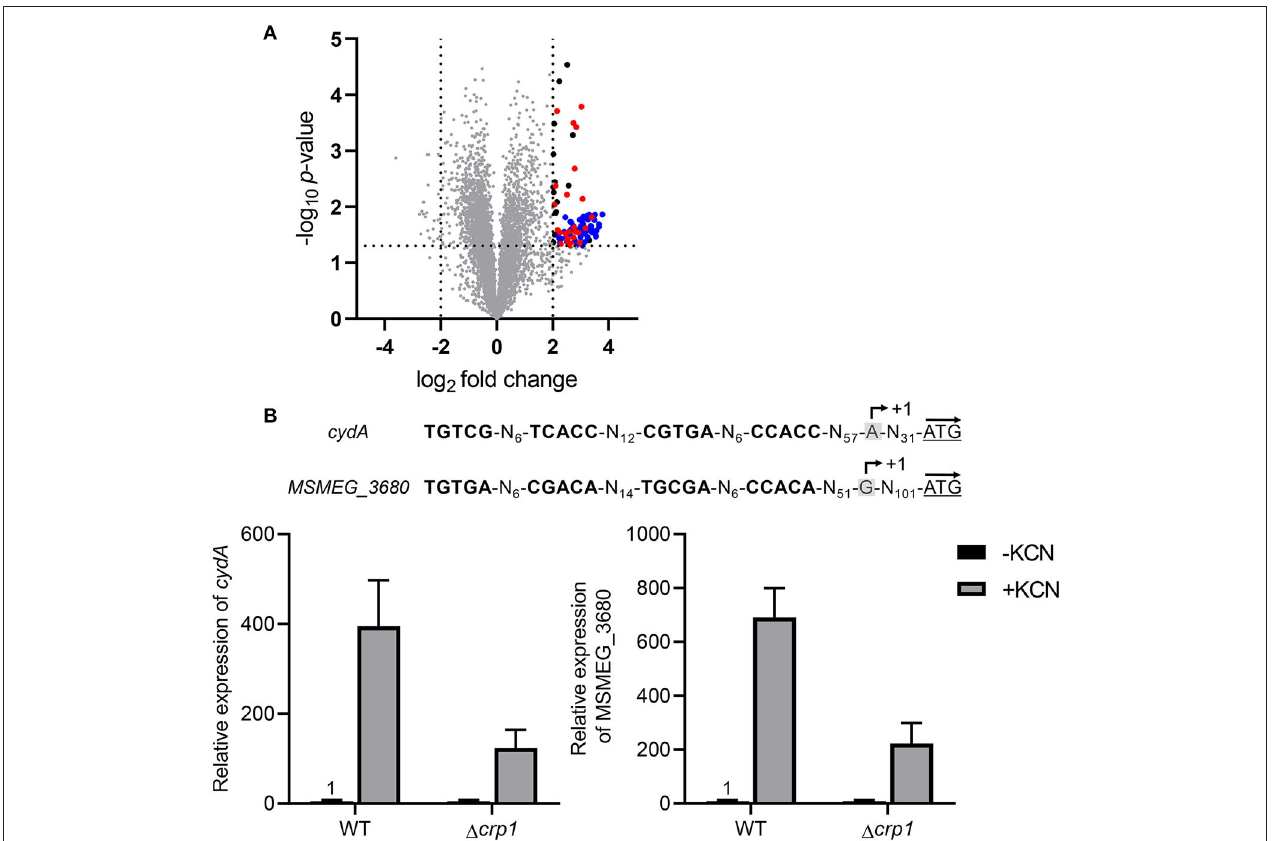
FIGURE 7 | Overlap of the SigF and Crp1 regulons with the genes induced in the 1 aa 3 mutant strain of M. smegmatis . (A) Volcano plot showing the DEGs in the 1 aa 3 mutant strain relative to the WT strain. RNA sequencing was performed using RNA prepared from three independent replicate cultures of the WT and mutant strains grown aerobically in 7H9-glucose medium to an OD 600 of 0.45–0.5. The x-axis displays the log 2 fold change of gene expression (log 2 FC) in the 1 aa 3 mutant relative to the WT strain, and the y-axis represents -log 10 p -value. The horizontal dotted line on the graph indicates the border line indicating the p -value of 0.05, and the vertical dotted lines indicate the border lines indicating the log 2 FC values of − 2 and + 2. One hundred and three genes, whose expression is increased by more than log 2 FC ≥ 2 with p < 0.05, are depicted by black filled circles. Among the 103 DEGs, the genes belonging to the SigF regulon are denoted by blue filled circles ( Singh et al., 2015), and the genes, whose expression is reduced by FC ≥ 1.5 with p < 0.05 in the 1 crp1 mutant strain relative to the WT strain, are indicated by red filled circles. (B) The nucleotide sequences and locations of the Crp-binding sites in the upstream regions of cydA and MSMEG_3680 and the expression levels of the genes in the WT and 1 crp1 mutant strains of M. smegmatis . The Crp-binding sites are shown in bold. The previously reported TSPs of cydA and MSMEG_3680 are denoted by + 1 ( Aung et al., 2014; Martini et al., 2019). The start codons of cydA and MSMEG_3680 are underlined, and the arrows above them indicate the transcriptional direction. The expression levels of cydA and MSMEG_3680 in the WT and 1 crp1 mutant strains were quantitatively determined